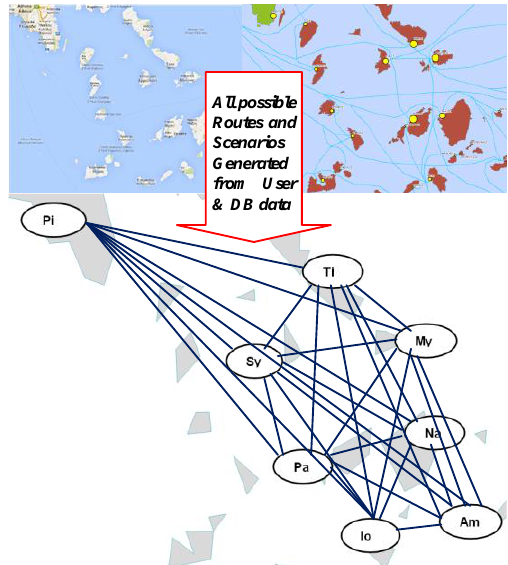
Figure 7. Based on user‟s selections, geo & traffic data are case under